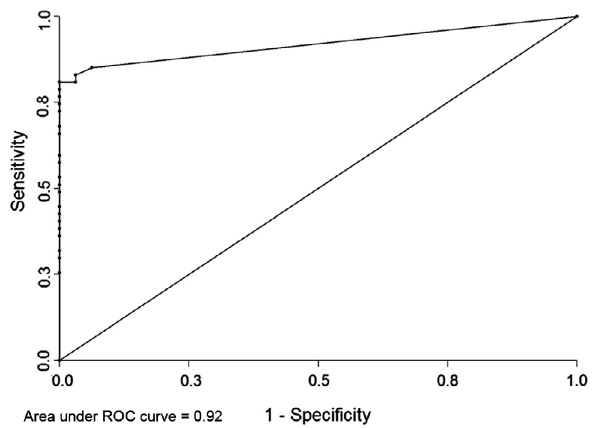
Figure 3. Receiver operating characteristic curve for 86 IgG negative (<6 UI/mL) or equivocal (6–9 UI/mL) and IgM positive